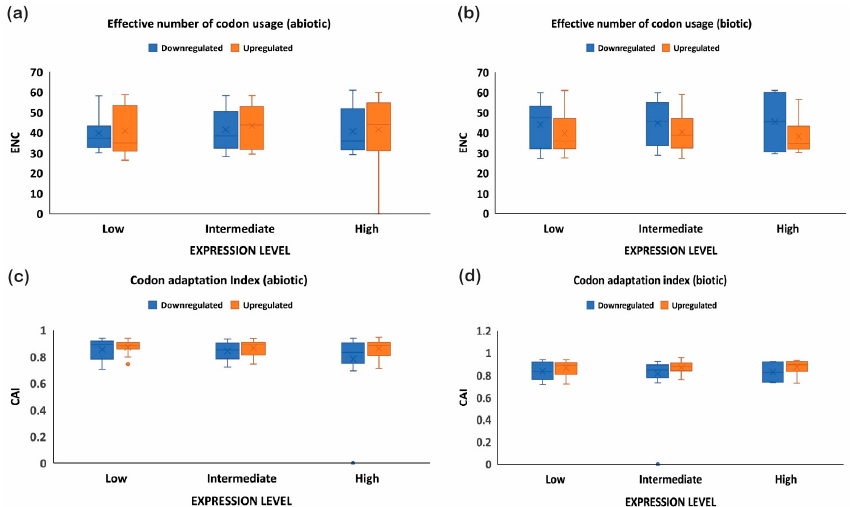
Figure 7. ENC and CAI analysis for upregulated and downregulated genes expressed under biotic and abiotic stress conditions. ENC analysis for ( a ) abiotic stress and ( b ) biotic stress, and CAI for ( c ) abiotic stress and ( d ) biotic stress. The upregulated genes have more ENC under abiotic stress than biotic stress, showing better adaptability, and vice versa. On the other hand, codon adaptation was higher in the upregulated genes than the downregulated genes.